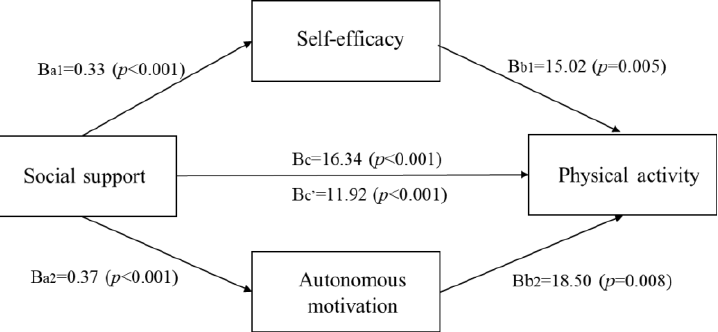
Figure 1. Parallel multiple mediation model testing self-efficacy and autonomous motivation as mediators of social support on physical activity.